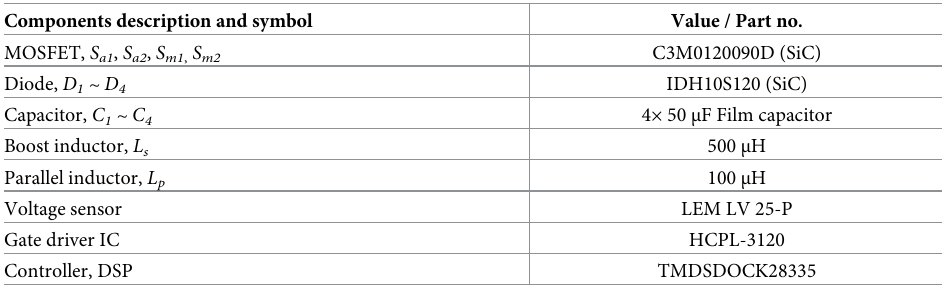
Table 4. Components description of proposed converter